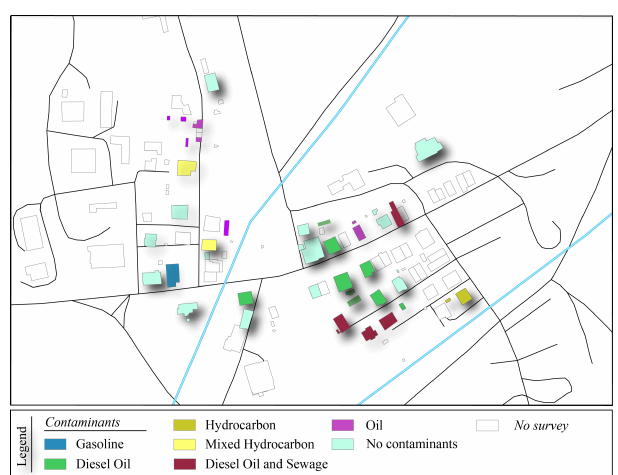
Figure 3. Flood zone in Orvieto 2